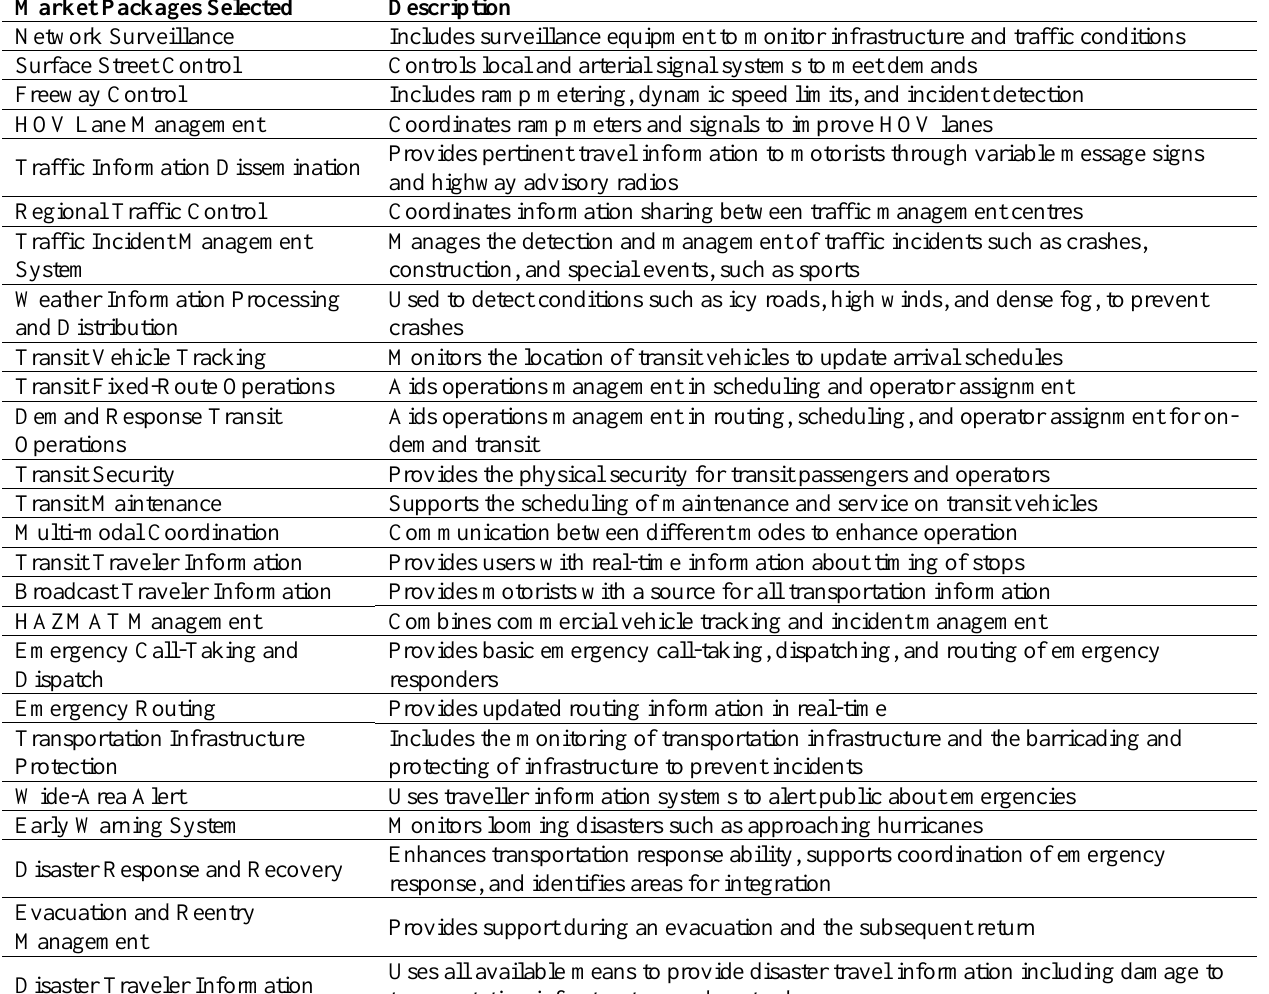
Table 1. Market Packages Selected for Greenville, South Carolina Market Packages